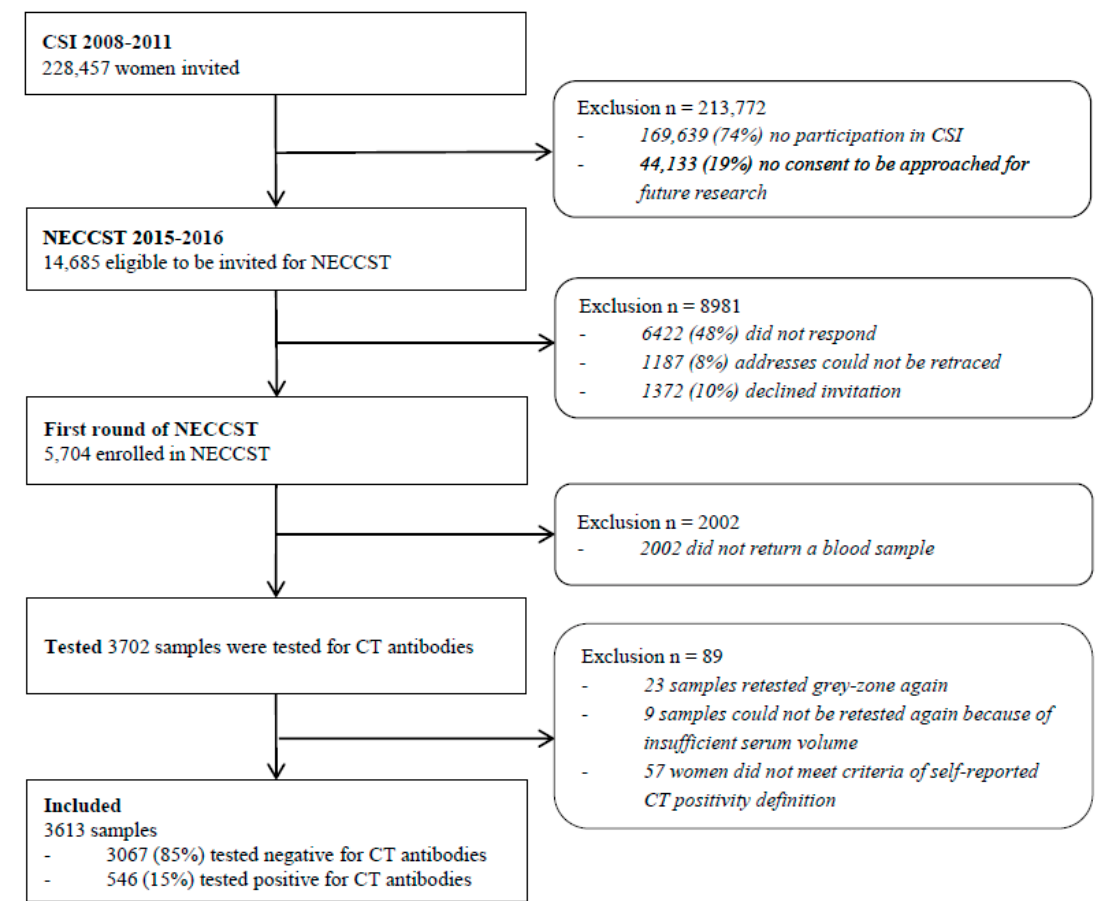
Figure 1. Flowchart for inclusion of participants in the present study, based on previous participation in the Chlamydia Screening Implementation (CSI) ( n = 58,818) and Netherlands Chlamydia Cohort Study (NECCST) ( n = 5704) projects .